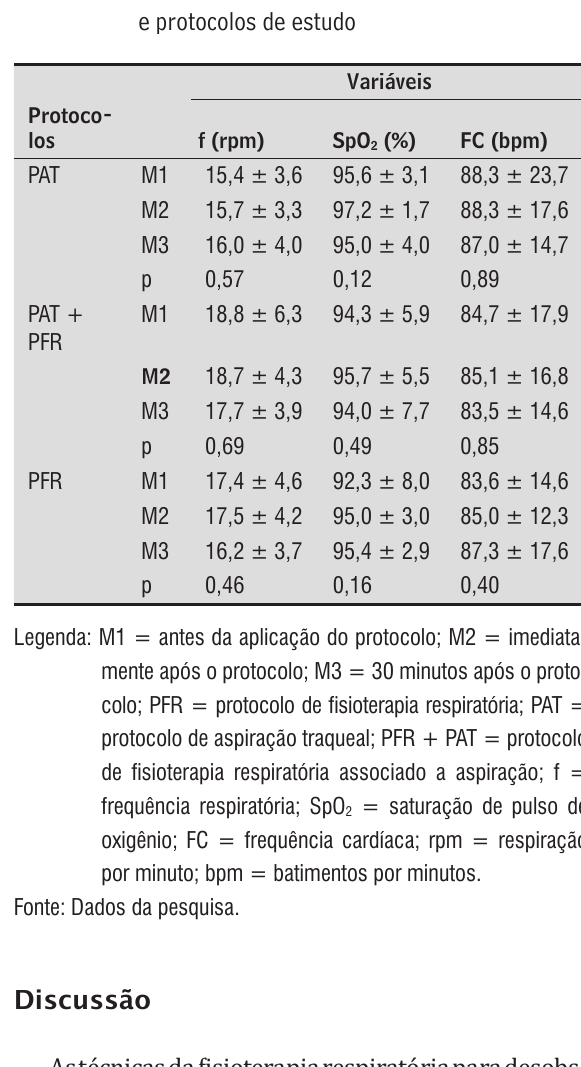
Tabela 2 - Média e desvio padrão da frequência